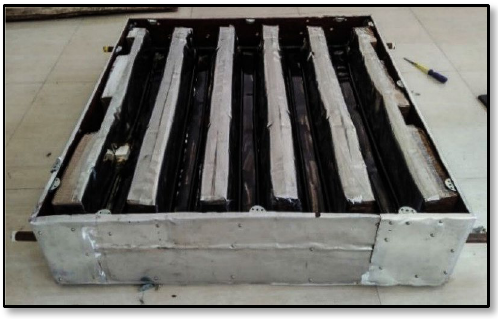
Figure 3. Geometry of CPC [18]